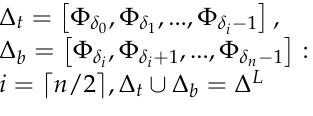
Figure 11. Amplitude distribution considered for function ξ in the experiments.